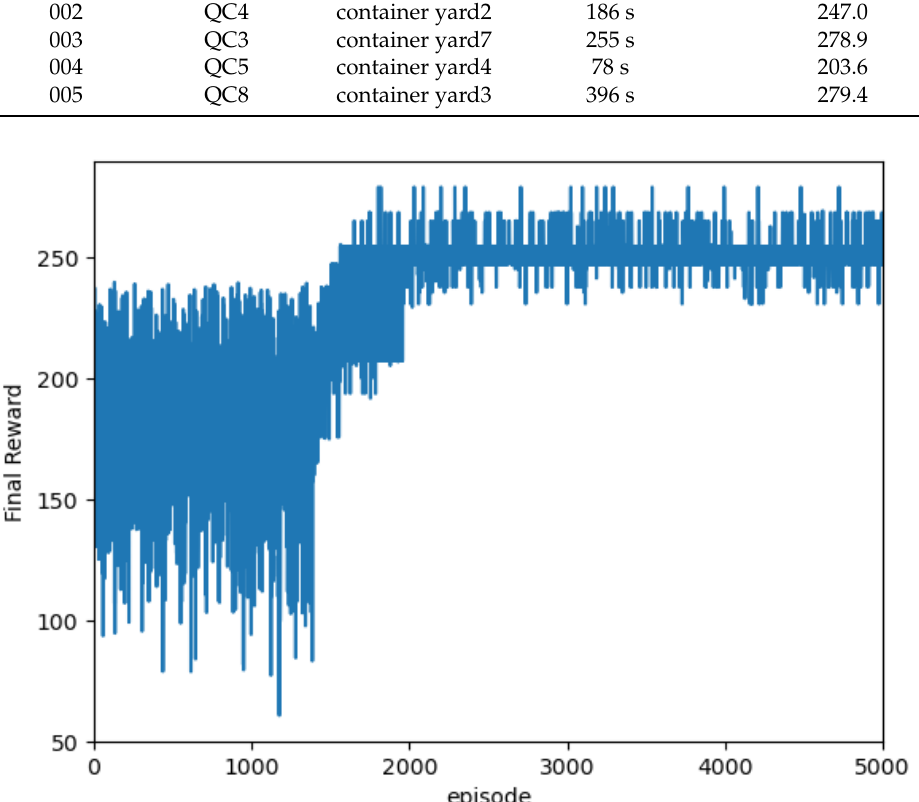
Figure 7. Final reward changing process during